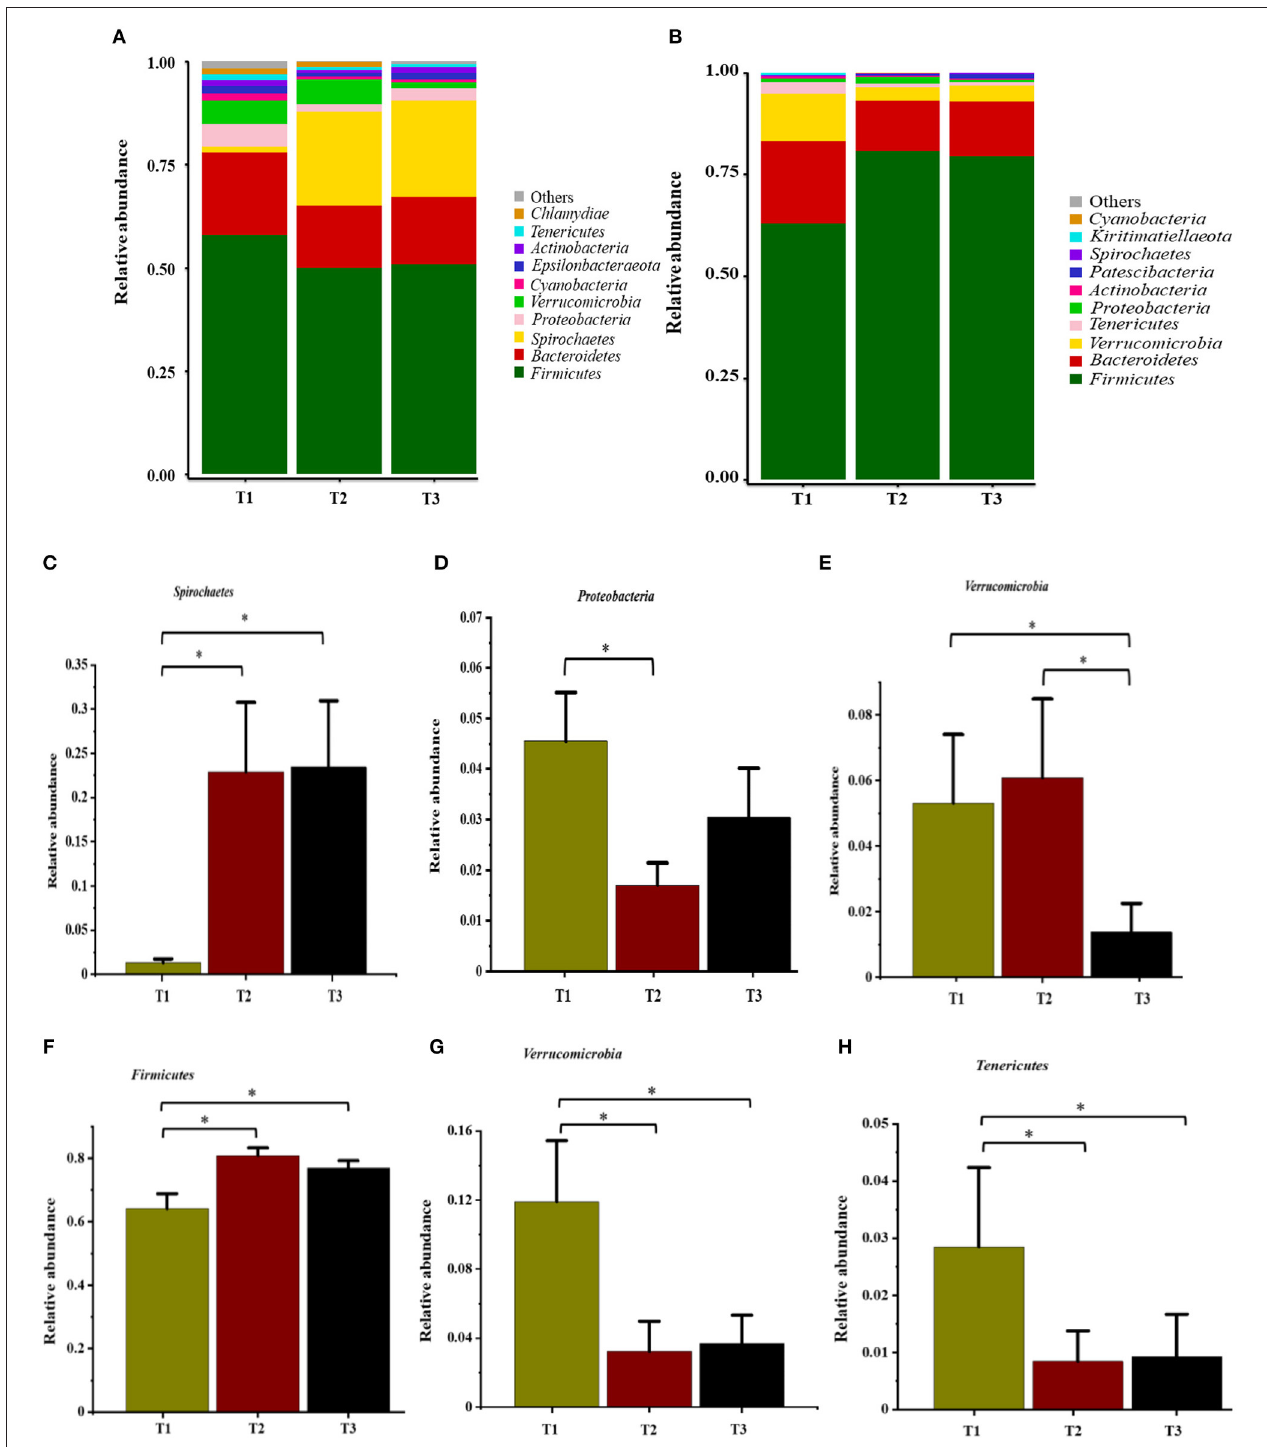
FIGURE 5 | Relative abundance of bacteria at the phylum level in the cecal mucosa (A) and digesta (B) . Comparison of relative abundances at phylum levels ( C–E , mucosa) and ( F–H , digesta) were analyzed by the Kruskal-Wallis rank-sum test. Values are expressed as means ± SEM indicated by vertical bars. *Significantly different means ( P < 0.05). T1 (normal corn 100%, high amylose corn 0%); T2 (normal corn 50%, high amylose corn 50%); T3 (normal corn 0%, high amylose corn 100%).